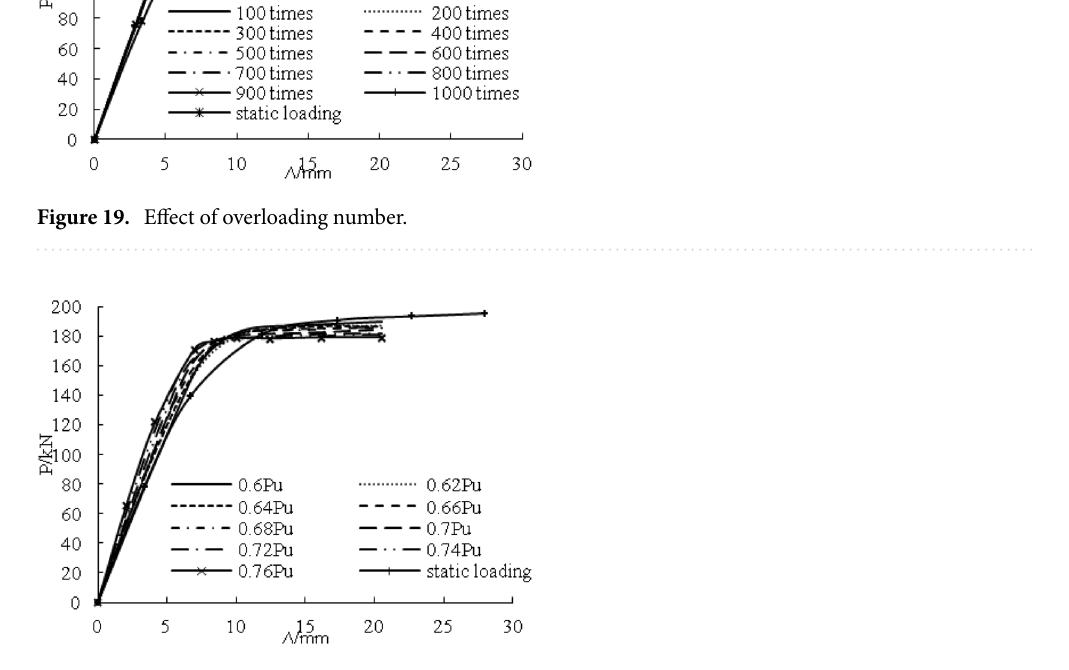
Figure 20. Effect of overloading